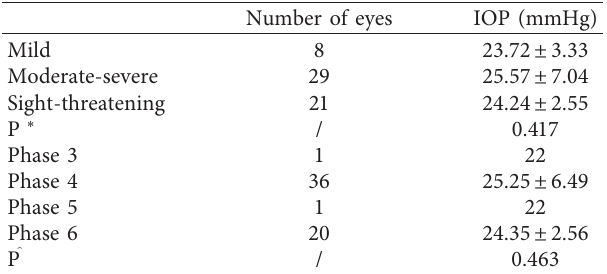
Table 2: Comparison of intraocular pressure (IOP) in severities of Graves’ orbitopathy.